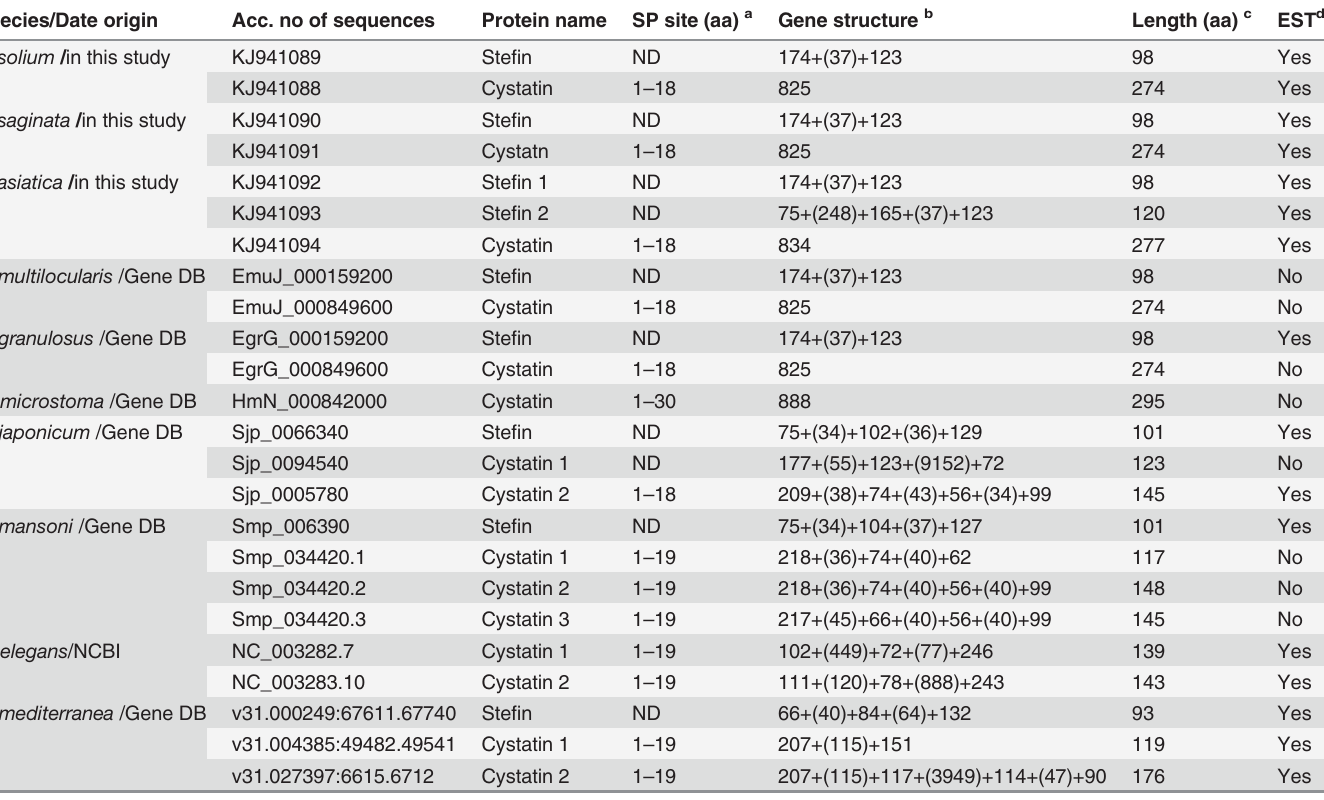
Table 2. Cystatin superfamily genes used for the deduced amino acid sequence alignment or phylogenic study in